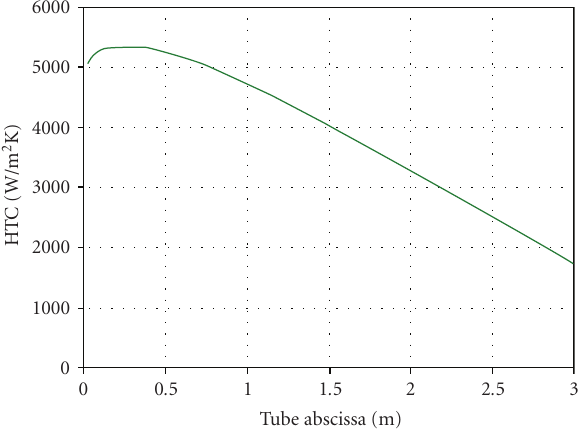
Figure 18: Condensation HTC along tube abscissa, according to Shah correlation (G = 61.5 kg/sm 2